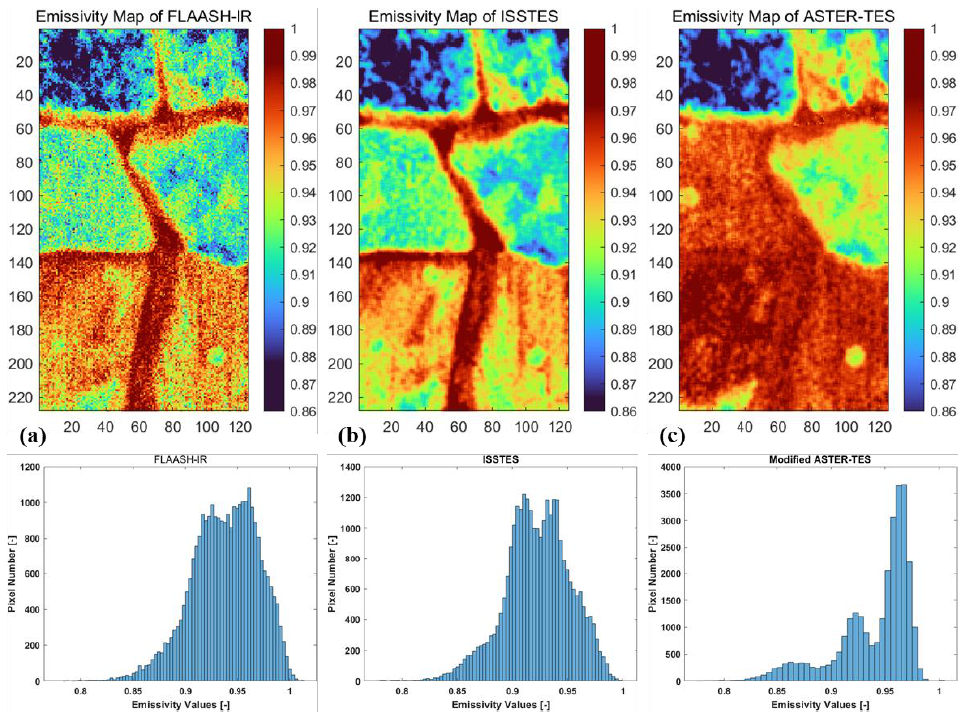
Figure 13. Retrieved emissivity maps in the 10 µm band: ( a ) result of FLAASH-IR; ( b ) result of ISSTES; ( c ) result of the modified ASTER-TES method.